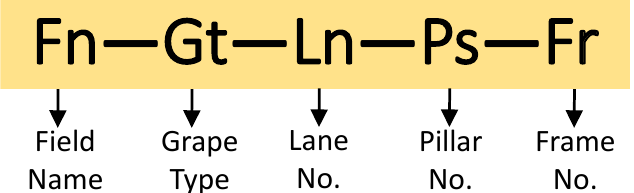
Figure 8. Format of data logging showing different sections separated by